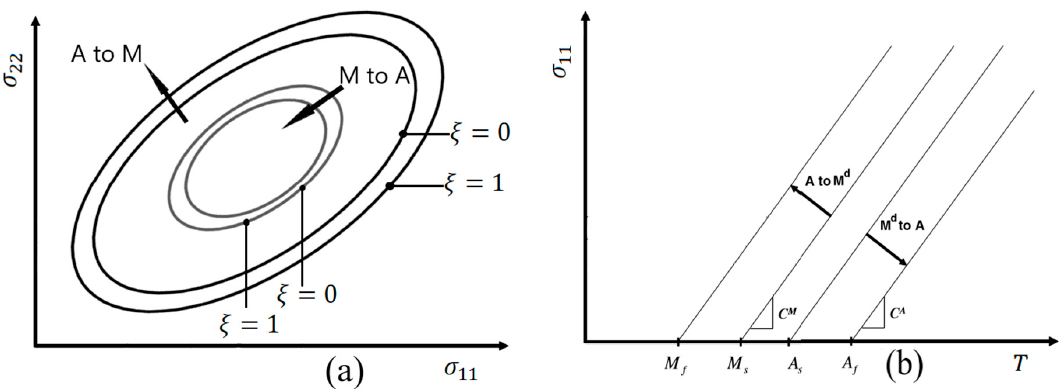
Figure A1. ( a ) Transformation surface plot in a two-dimensional stress space for forward and reverse phase transformation at a given fixed temperature (T = 308 K); ( b ) schematics of stress-temperature phase diagram for an SMA.